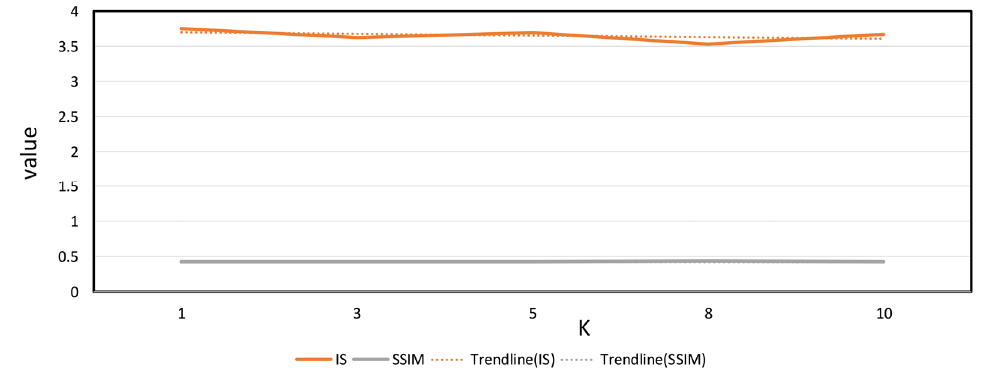
Figure 4. Trend plots of IS and SSIM scores for the SAM-GAN- K ( K = 1, 3, 5, 8, 10) model on the test set.